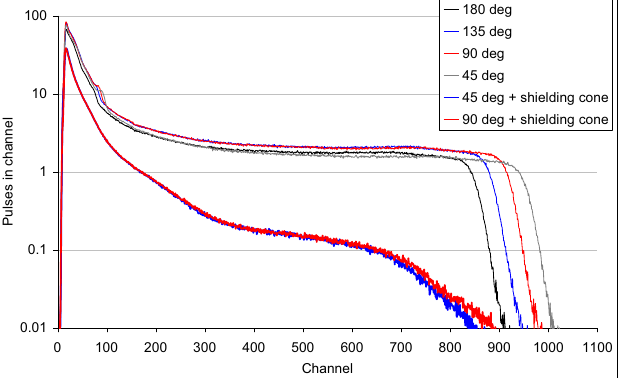
Figure 5. Apparatus spectra in various angles from the Ostrava D-T